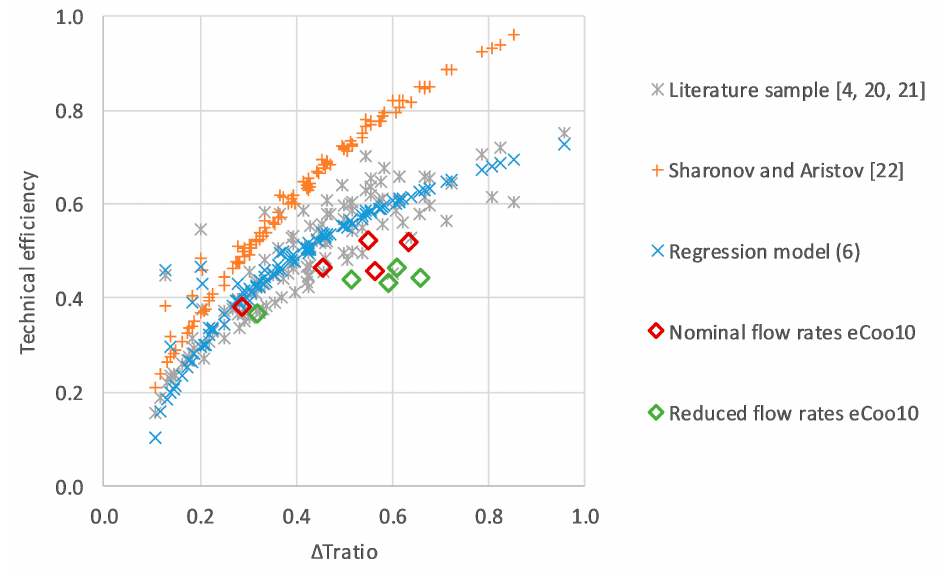
Figure 12. Technical e ffi ciency as a function of the ∆ T ratio for the literature sample [4,20,21], thermodynamic proposed in [22], the regression model given in (6) and the experimental results of the eCoo10. Table 6. Comparison of the experimental results with the model predictions.